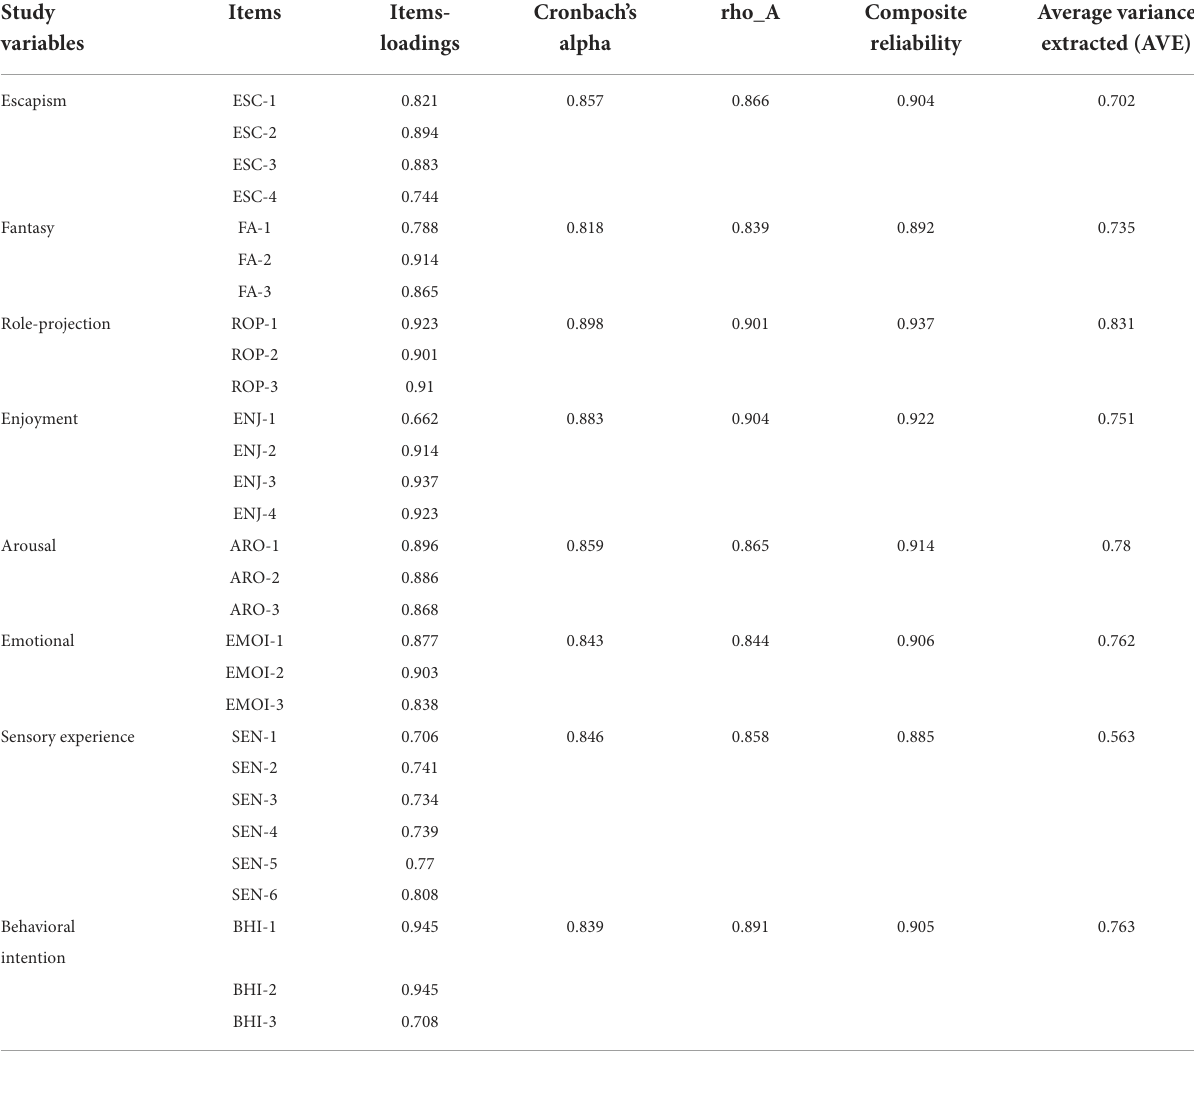
TABLE 2 Construct reliability and validity.